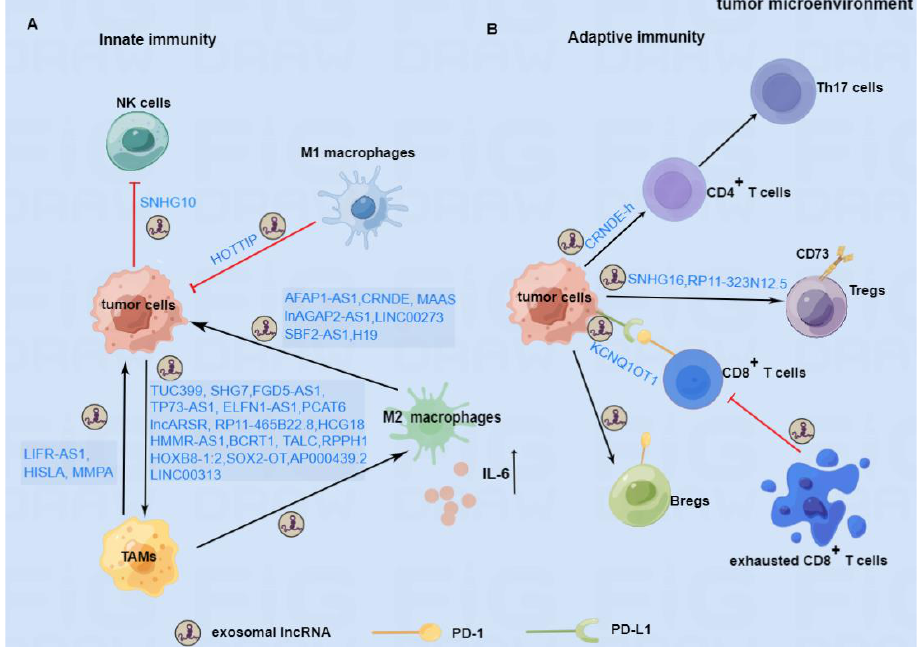
Figure 2. The immunomodulatory role of exosomal lncRNAs in TME. ( A ) In innate immunity, tumor cells can secret exosomal lncRNAs to boost the polarization of M2 macrophages or inhibit the killing function of NK cells. TAMs and M2 macrophage-secreted exosomal lncRNAs can support the progression of tumor cells, whereas M1 macrophage-derived exosomal lncRNA may inhibit the progression of tumors. ( B ) In adaptive immunity, tumor cells can secrete exosomal lncRNAs to promote the differentiation of Th17 cells, Tregs, and Bregs and the PD-1 expression on the surface of Bregs, which are beneficial to the progression of tumors. In addition, tumor cells can also secrete exosomes containing lncRNAs to maintain the PD-L1 expression on their surface, thus restraining the biological function of CD8 + T cells. Furthermore, exhausted CD8 + T cells can also produce certain exosomal lncRNA to impair the ability of normal CD8 + T cells. LncRNAs involved in the mechanism of immune regulation are depicted above.